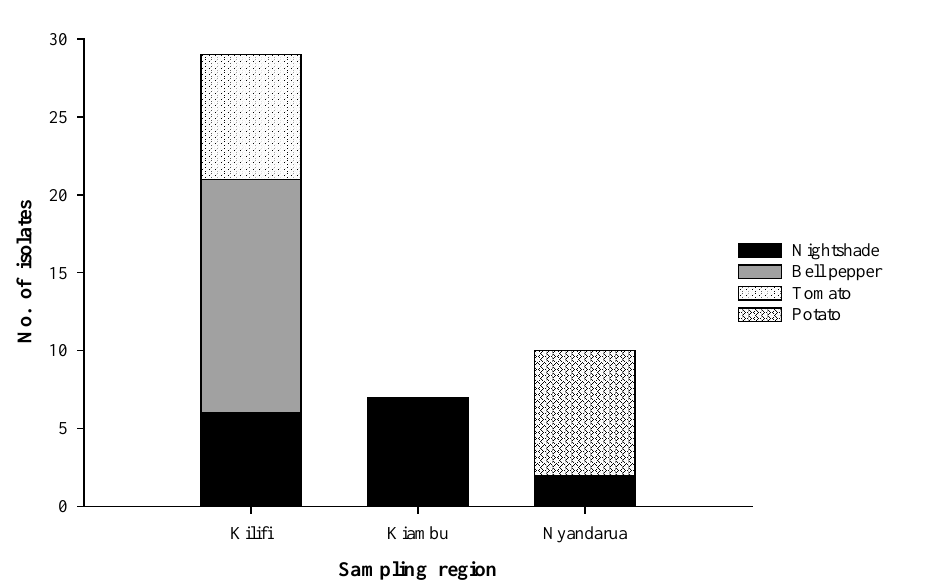
Figure 2. Distribution of root fungal endophytes with potential activity against P. infestans in relation to host plant and sampling region.